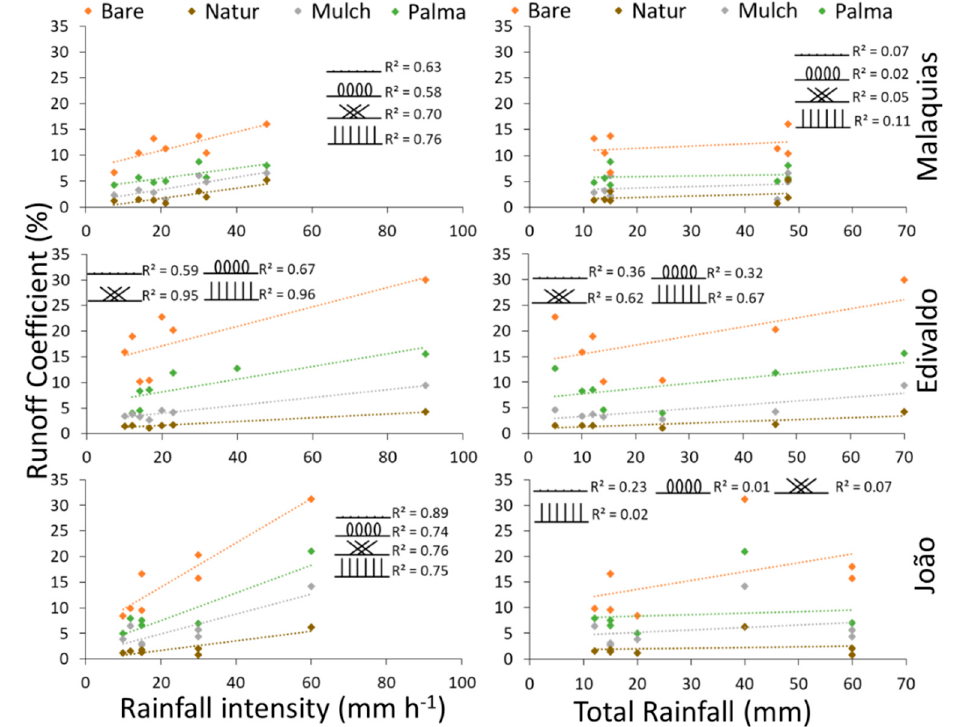
Figure 6. Runoff coefficient as a function of rainfall volume and intensity, for all sites and plots.